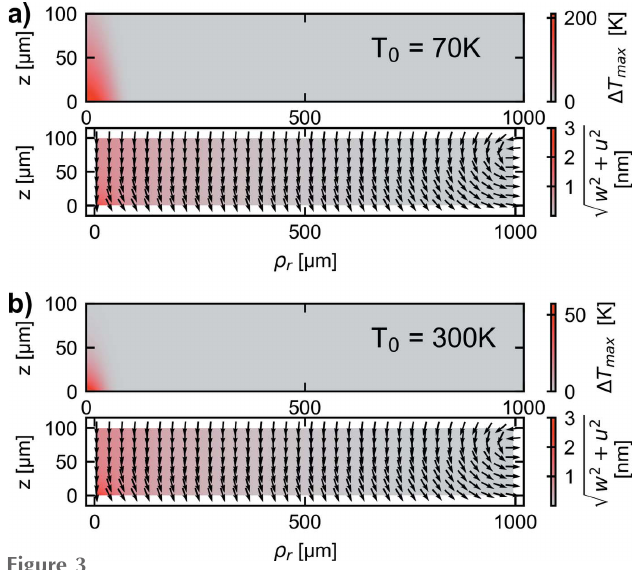
Figure 3 Comparing the heat bump profile and temperature rise for different initial temperature values for a cylindrical diamond crystal. In ( a ) the initial temperature is T 0 = 70 K and in ( b ) it is T 0 = 300